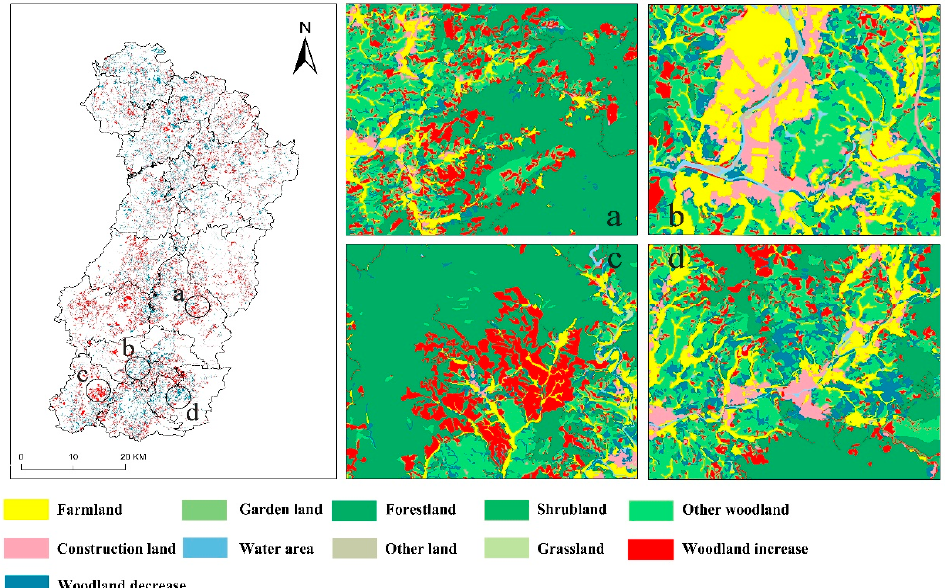
Figure 3. Spatial transfer of woodlands in Anyuan County, 2009–2019. （ a indicates an increase in woodland around farmland, b indicates a decrease in woodland around farmland and construction land, c indicates an increase in woodland around garden land, and d indicates a decrease in wood- land around garden land. ）